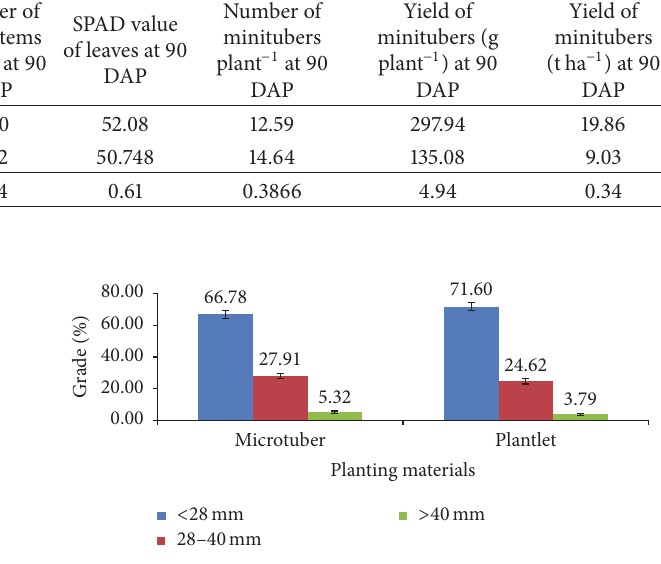
Figure 2: Effect of planting materials on production of minituber grades according to